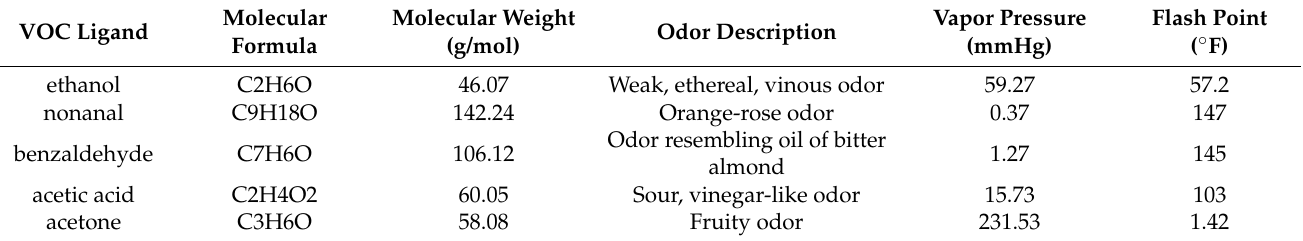
Figure 1. Structure of SARS-CoV-2-related VOC biomarker. Table 1. Summary of representative SARS-CoV-2-related VOC ligand.